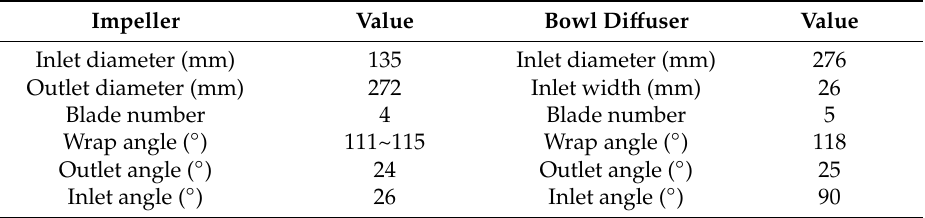
Table 1. Geometric parameters for the test centrifugal